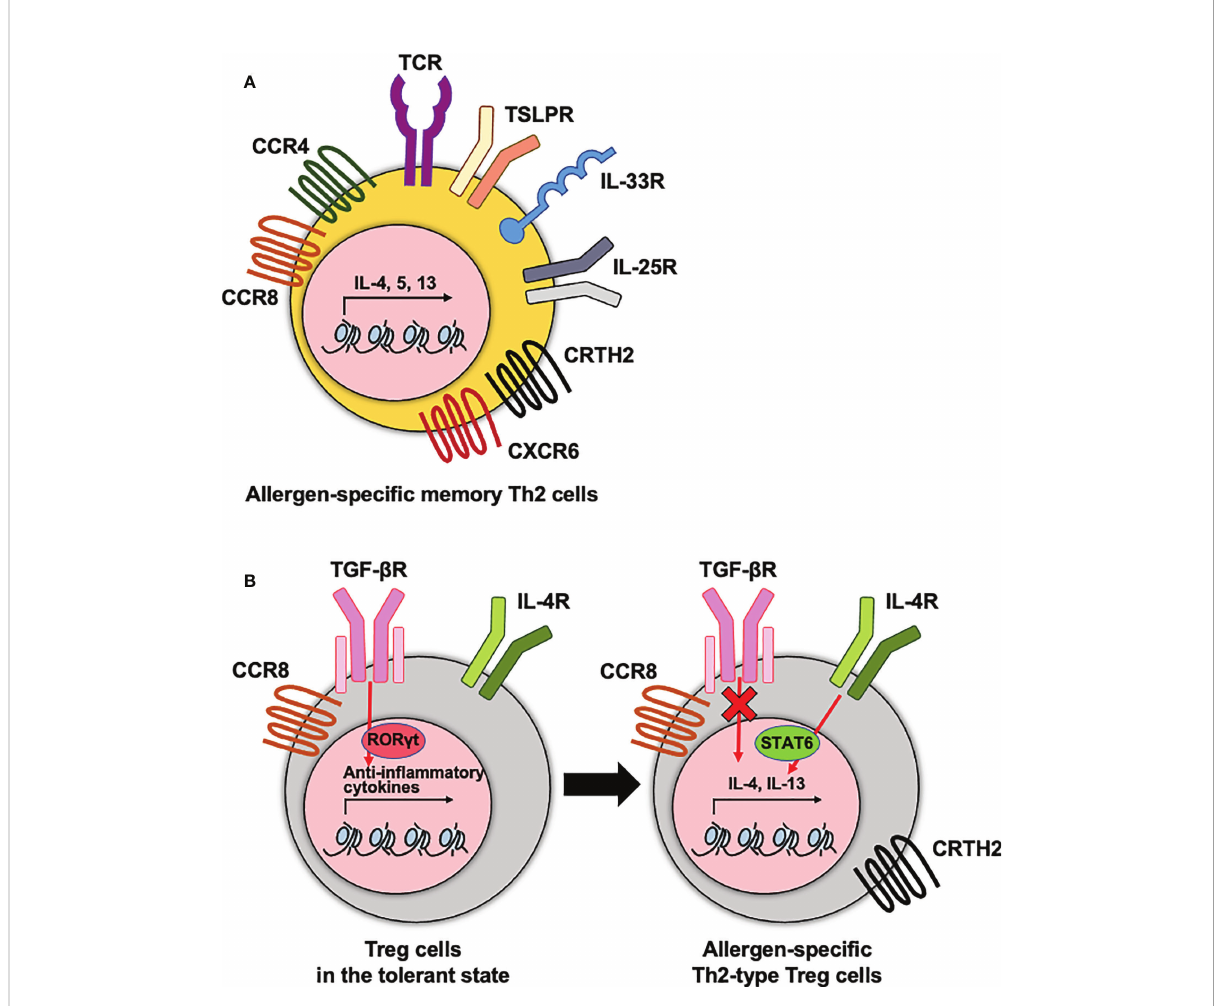
FIGURE 1 The phenotypes of allergen-speci fi c memory CD4 T cells and Treg cells. (A) Allergen-speci fi c memory Th2 cells express diverse cytokine and chemokine receptors that are correlated with the pathogenesis of allergic diseases. (B) Treg cells express diverse cytokine and chemokine receptors. To maintain the immune tolerance, TGF- b R needs to be expressed on Treg cells. This receptor signaling mediates ROR g t transcription factor for anti-in fl ammatory functions of Treg cells. In dysfunctional Treg cells, hyperactive IL-4-STAT6 axis and no TGF- b signaling enhances type 2 cytokine production. These receptors contribute to the type 2 cytokine production by Th2 cells and dysfunctional Th2-type Treg cells during the pathogenesis of allergic